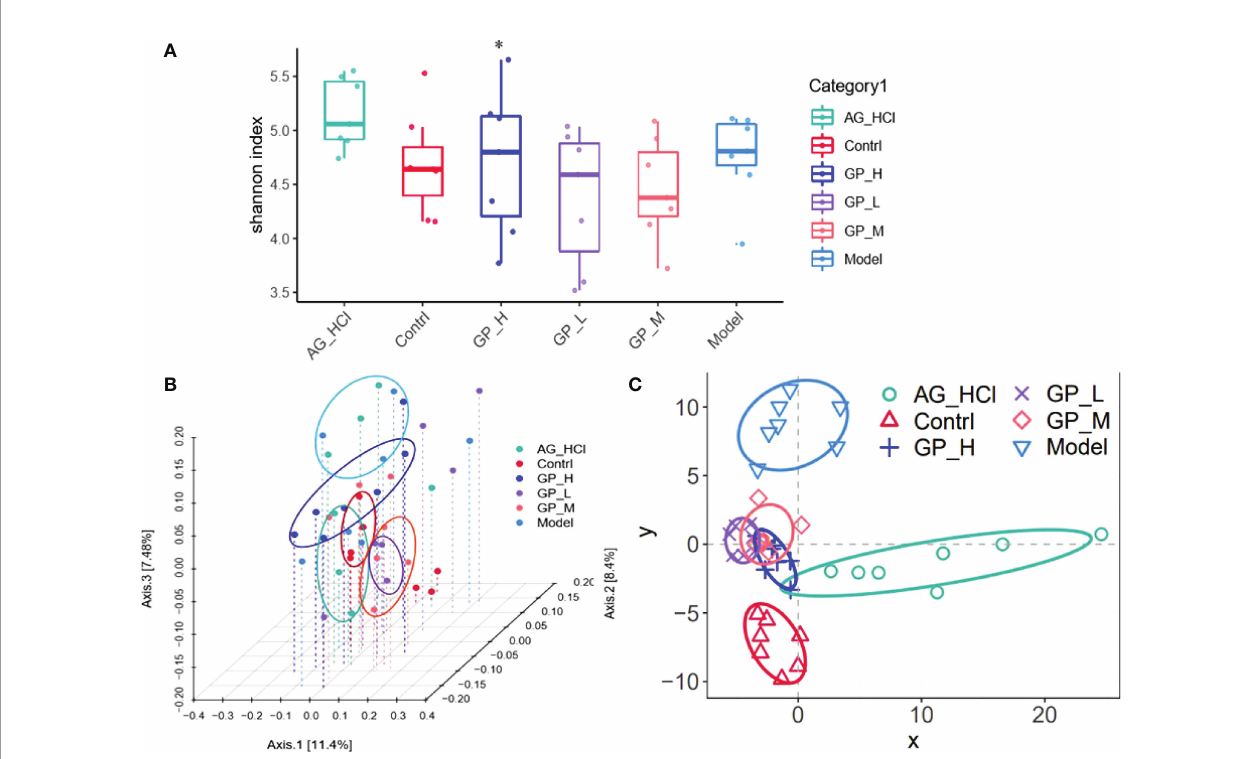
FIGURE 9 | Shannon index box fi gure of mice intestinal micro fl ora (*p < 0.05 vs. model group) (A) PCoA analysis of the diversity of mice intestinal micro fl ora (B) PLS-DA analysis based on OTU abundance (C)